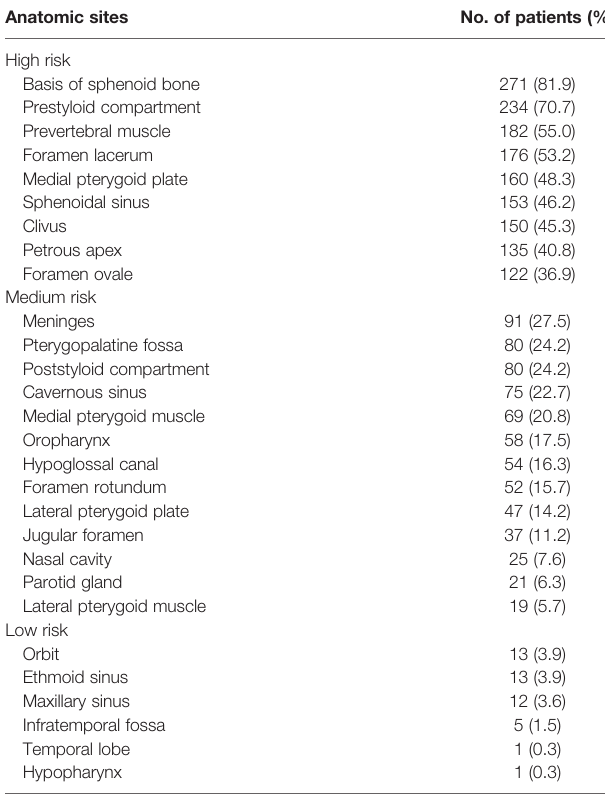
TABLE 2 | Incidence rates of tumor invasion into anatomic sites for nasopharyngeal carcinoma. Anatomic